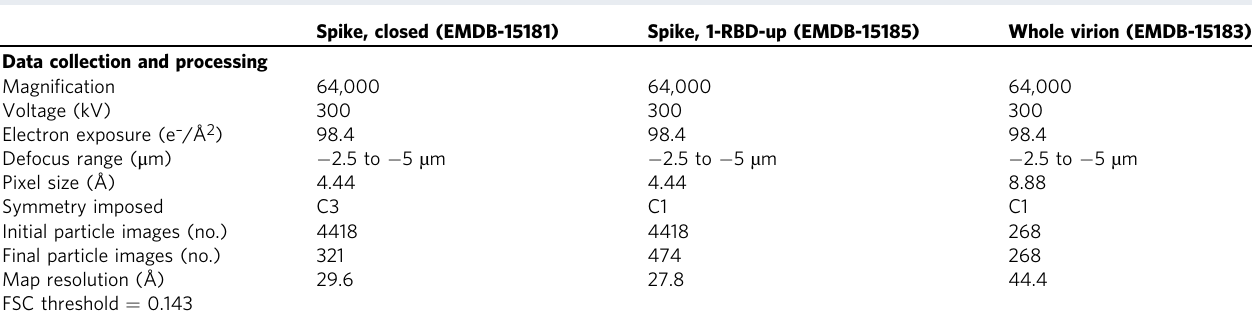
Table 1 Cryo-EM data collection, re fi nement and validation